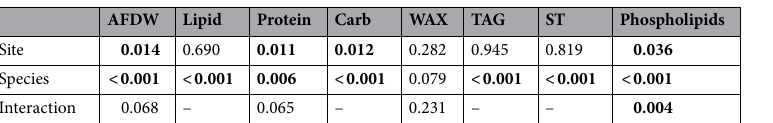
Table 1. Significant p-values for energy reserves and lipid analyses. Kruskal–Wallis tests were used to determine significance for lipid, carbohydrate, TAG and ST. Two-way ANOVAs were used for AFDW, protein, WAX, and phospholipids with. Variables had df = 1 and 5 for site and species, respectively. Significant p-values (p < 0.05) are in